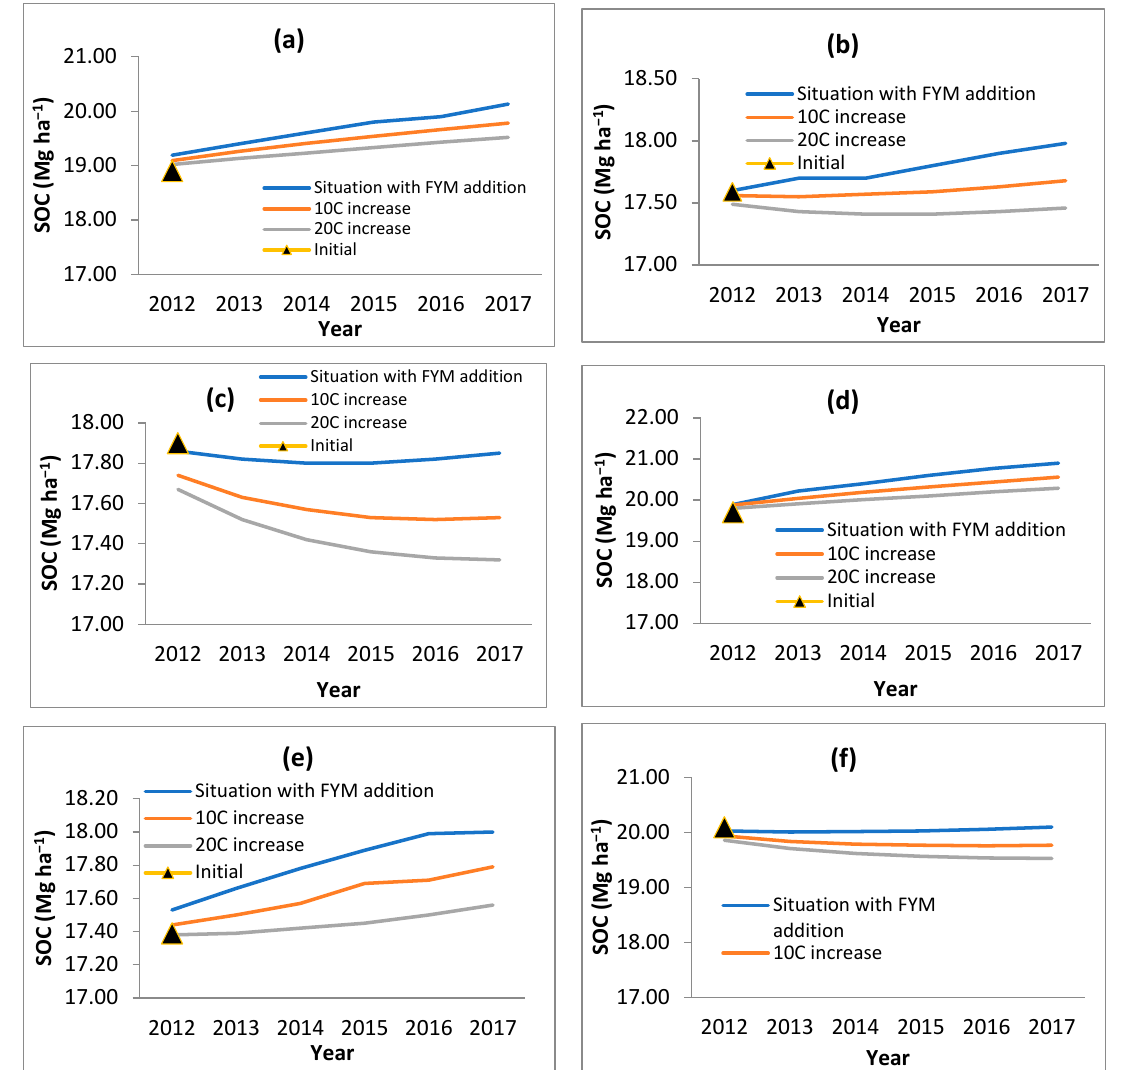
Figure 7. Effect of temperature increase on SOC with FYM addition @ 9 t ha − 1 ( a ) B. balcooa , ( b ) B. bambos , ( c ) B. nutans , ( d ) D. hamiltonii , ( e ) D. stocksii and ( f ) D. strictus .